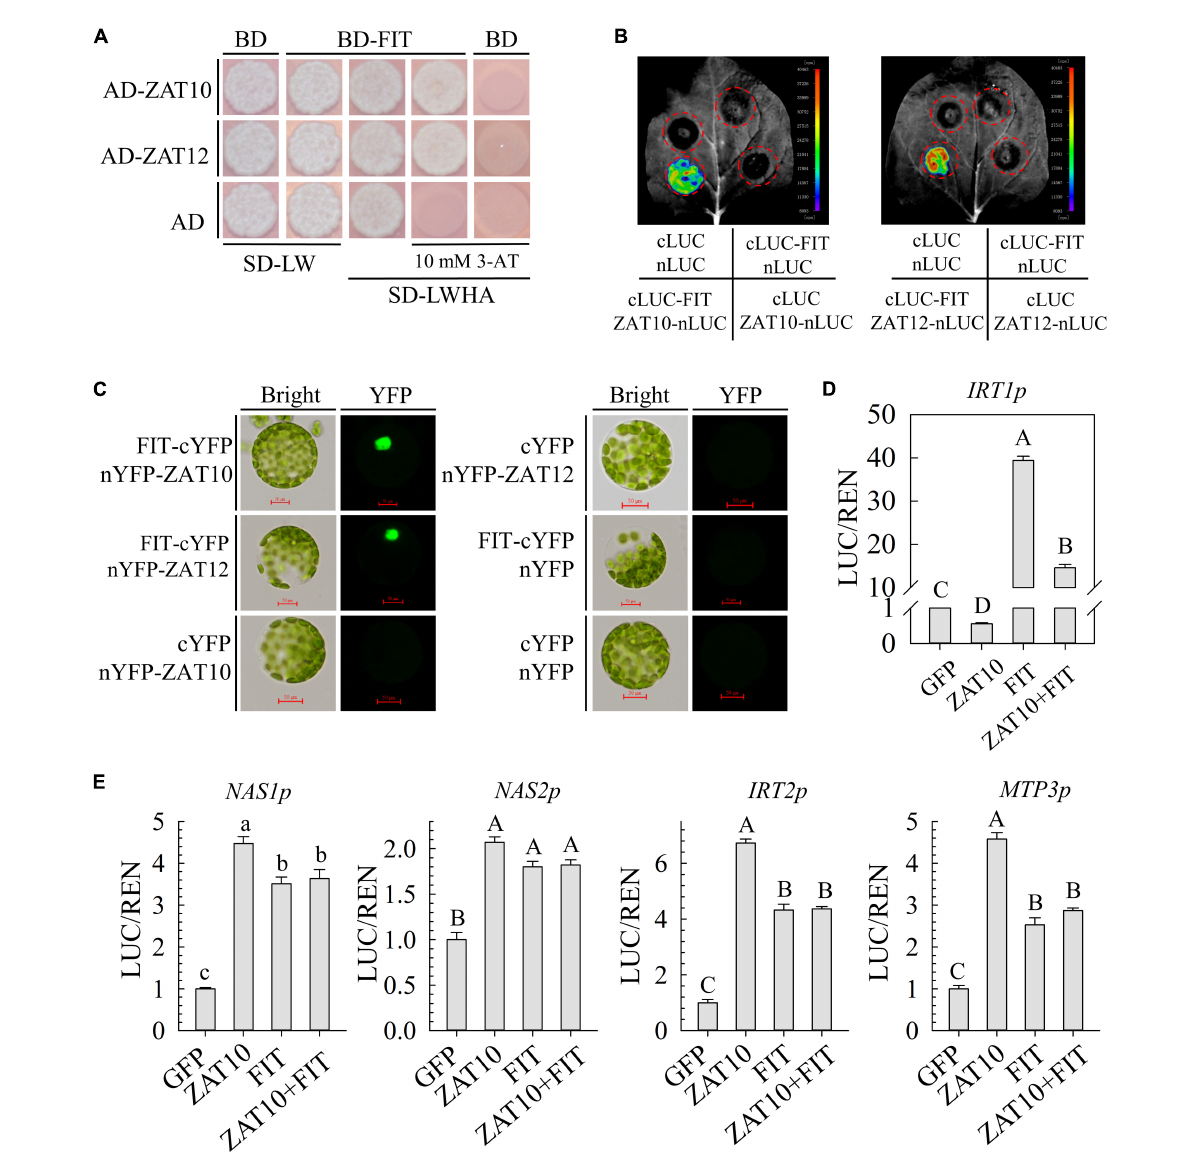
FIGURE6 ZAT10 interacts with FER-like iron deficiency-induced transcription and co-regulates the transcriptional expression of IRT1 . (A) ZAT10 interacts with FIT in yeast. 10 mM 3-AT was applied to inhibit the self-activation. ZAT12 was applied as a positive control. (B) luciferase complementation imaging assay confirms the interactions between FIT and ZAT10 or ZAT12 in N. benthamiana leaves. At least three replicates were observed with similar results. (C) BiFC assay confirms the interactions between FIT and ZAT10 or ZAT12 in Arabidopsis mesophyll cell protoplasts. At least three replicates were observed with similar results. Bar = 50 µ m. (D) ZAT10 represses the transcriptional activation of FIT on IRT1p:LUC in Arabidopsis protoplasts. (E) ZAT10 has no effect on the transcription activity of FIT on NAS1p:LUC , NAS2p:LUC , IRT2p:LUC , and MTP3p:LUC in Arabidopsis protoplasts. Means ± SD, n = 3; Significant differences are indicated by letters (lowercase P < 0.05 or uppercase P < 0.01. Tukey’s multiple comparisons